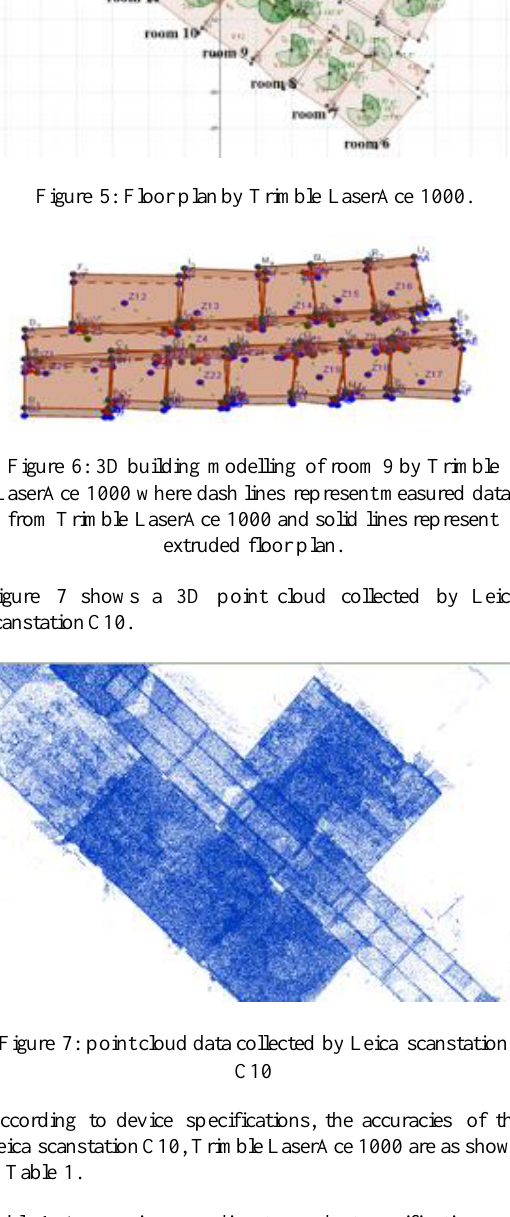
Table 1: Accuracies according to product